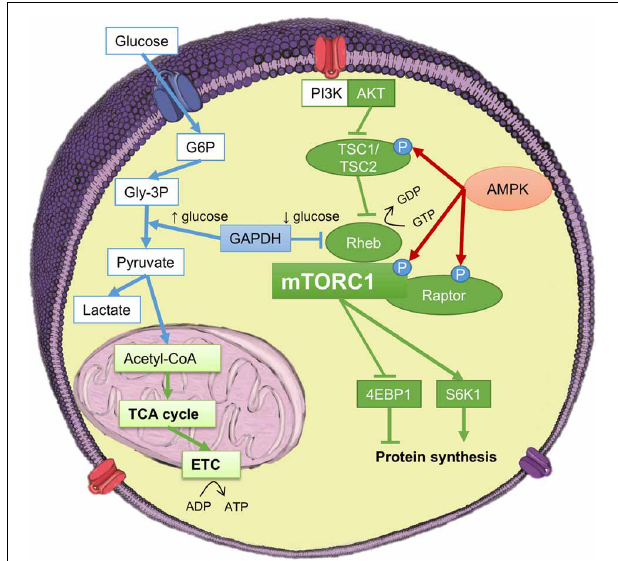
FIGURE 2 | Considered one of the master regulators of protein synthesis, mammalian target of rapamycin (mTOR) is perfectly positioned to receive feedback regarding the cellular energy status. During levels of high glycolytic flux, the ADP/ATP ratio is low, and so AMPK activity is reduced, furthermore, GAPDH is prevented from interacting with the small GTPaseRheb. Together, these pathways lead to elevated mTOR complex I (mTORCI) signaling, and protein